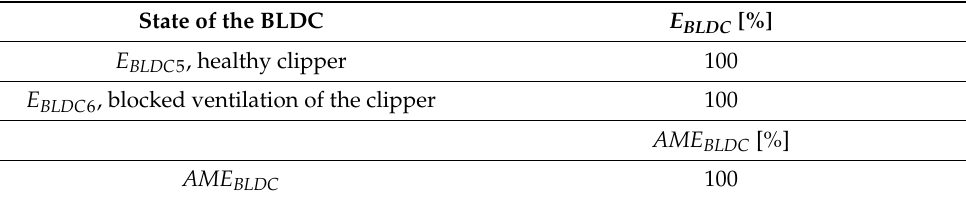
Table 4. Results of recognition for CPoAMoTI method (parameter p = 0–1.0) for the BLDC motor (Clipper